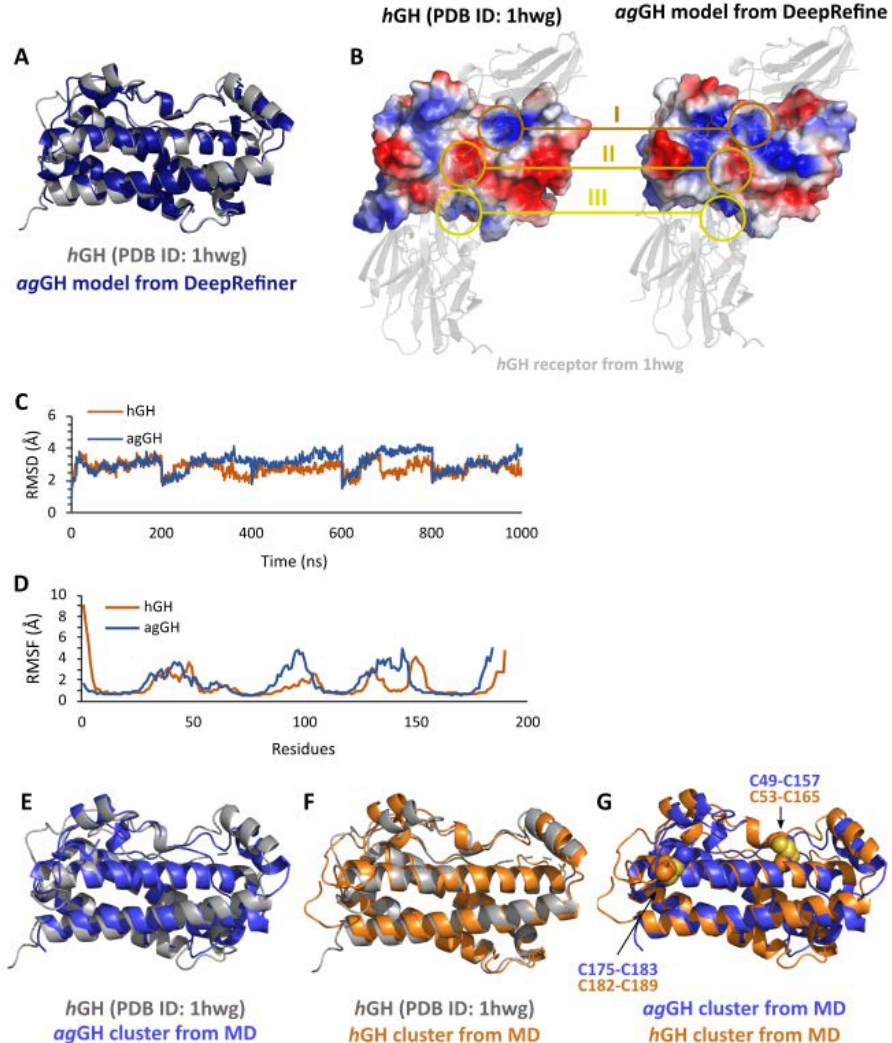
Figure 4. Superimposition of the template (PDB ID: 1hwg) and the refined structure ( A ). A comparison of the electrostatic potential surfaces (ranging from red, the electron-rich region, to blue, the electron-deficient region) of the template structure with that of the refined initial ag-GH model and with the PDB structure of the hGH receptor, shown as a transparent grey cartoon ( B ). RMSD ( C ) and RMSF ( D ) values were calculated for C-alpha atoms during the whole trajectories for both the ag-GH model (dark blue) and the hGH model (dark orange). The RMSD plot is presented as five subsequentially concatenated 200 ns replicas resulting in a single plot of 1 μs. Superimposition of the ag-GH model (blue) retrieved from the cluster analysis of the MD simulations with the experimental template structure (grey) ( E ). Superimposition of the hGH model (orange) retrieved from the cluster analysis of the MD simulations with the experimental template structure (grey) ( F ). Superimposition of the ag-GH model (blue) and the hGH model (orange) retrieved from the cluster analyses of the MD simulations. The two disulfide bonds are displayed in sphere representation ( G